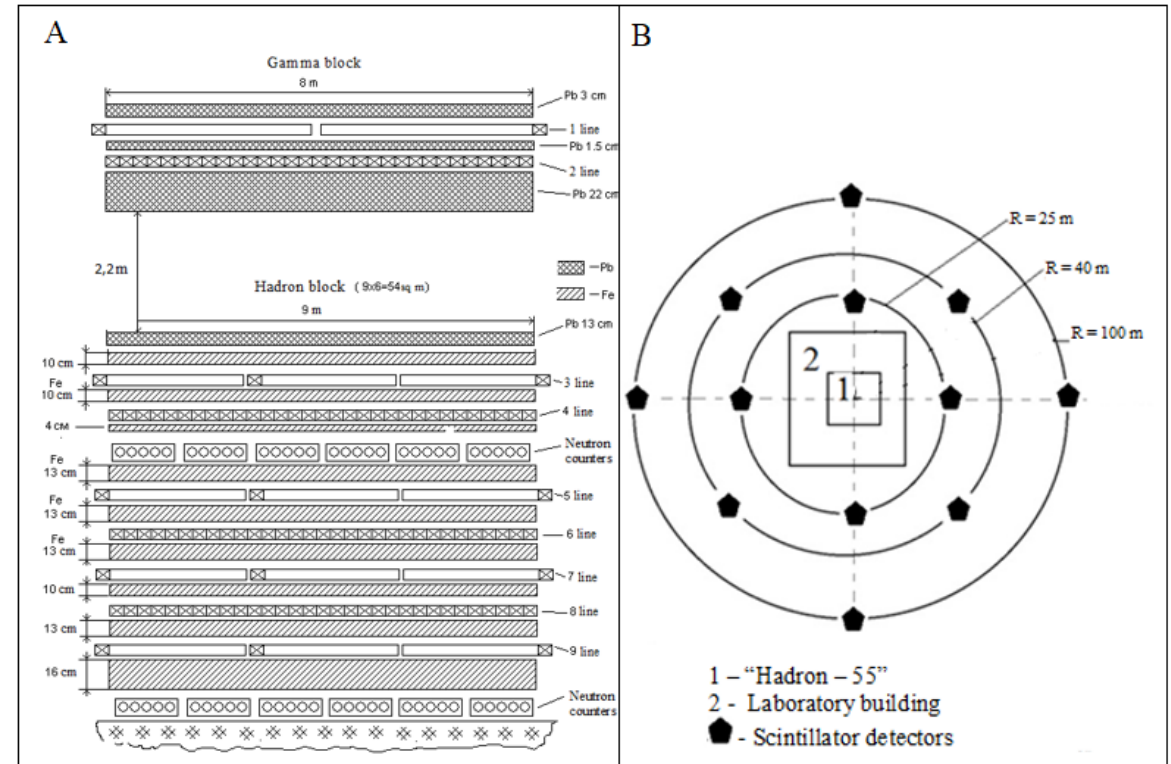
Figure 4. Upgraded ionization calorimeter with a field of scintillation detectors. ( A ) Installation Hadron-55; ( B ) infrastructure.